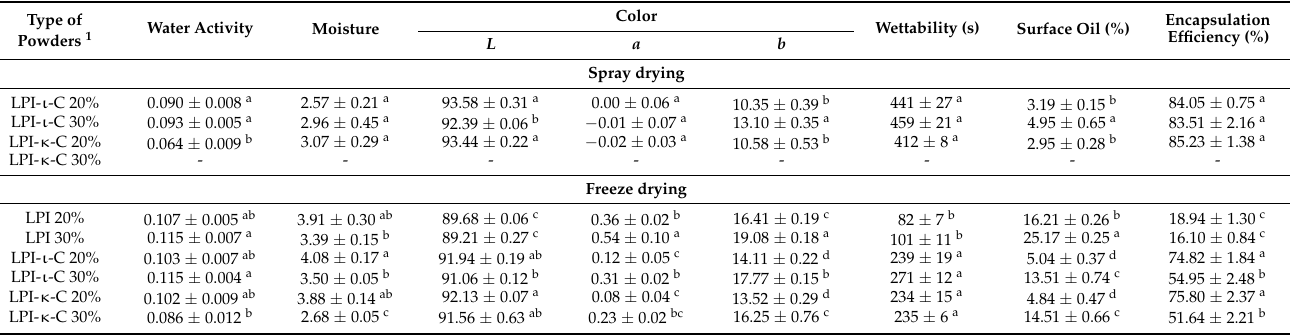
Table 3. Physical characteristics of spray-drying and freeze-drying powders. Data represents the mean ± one standard deviation ( n =